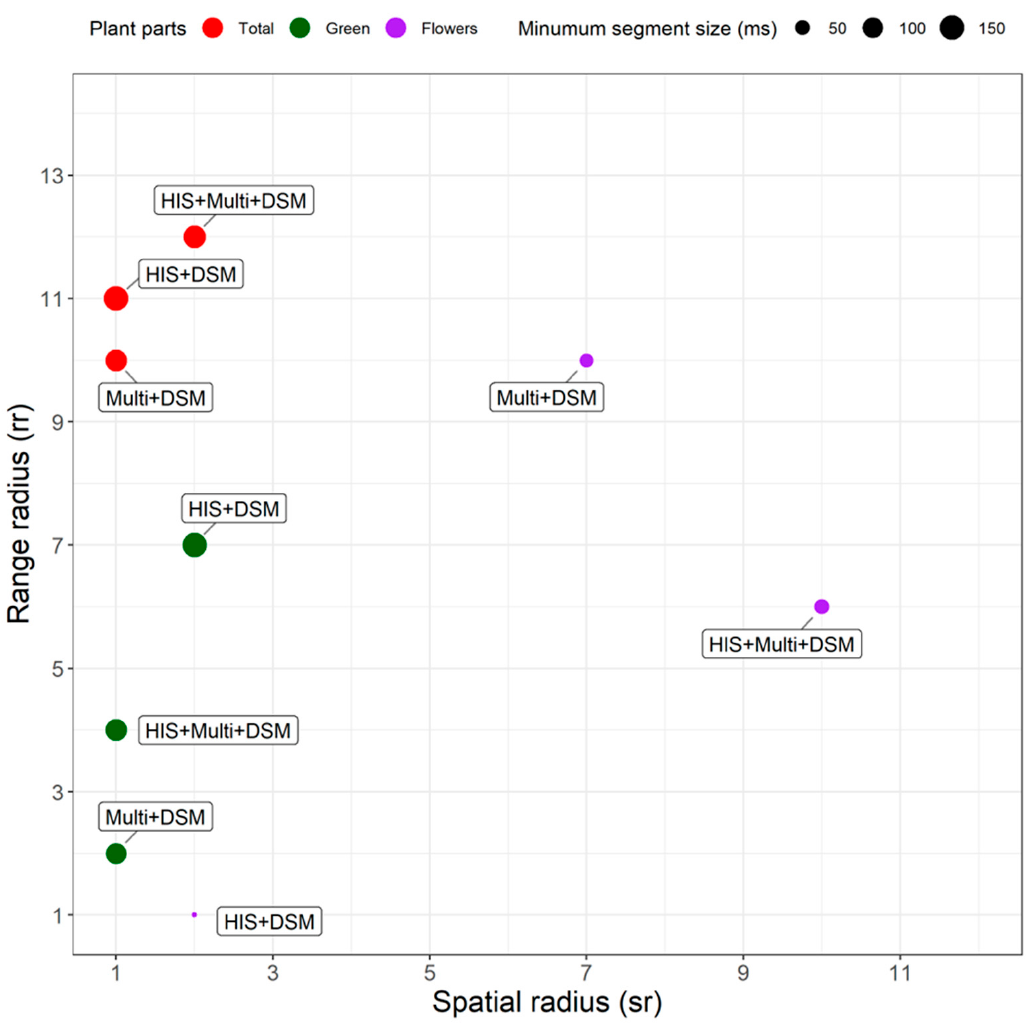
Figure 4. Graphical representation of optimised LSMS segmentation parameters. The x and y axes represent spatial radius (sr) and range radius (rr), respectively, while the point size is given by minimum segment size (ms). The points are also coloured according to the different parts of the plant analysed and bear the labels for the variable dataset used for optimisation.